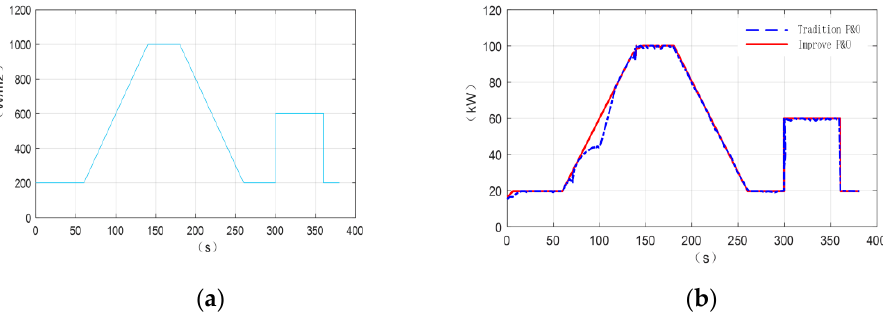
Figure 15. Photovoltaic power generation system simulation diagram. ( a ) Irradiance variation diagram; ( b ) output power curve diagram.